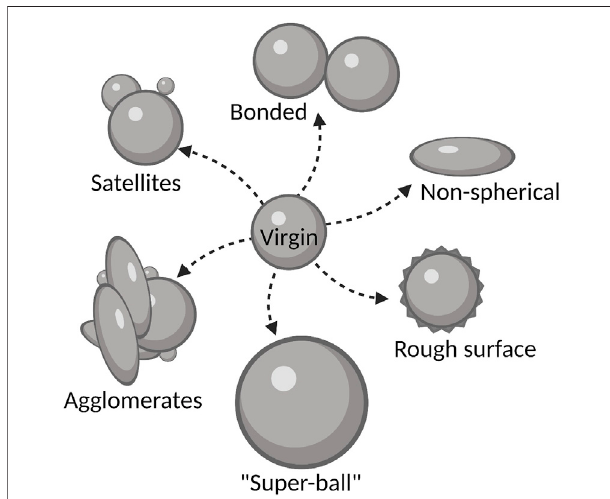
FIGURE2 | Impact ofreuse on the properties ofmicroparticlefeedstock powders in AM. Large energy input during production usually elicits formation ofsatellites(smallparticlesattachedtothesurfaceofbiggerparticles),bonded particles, non-spherical and elongated particles, tightly bound agglomerates, particles with rough/irregular surface topography or “ super- ball ” particles with increased size in comparison to the virgin particles.